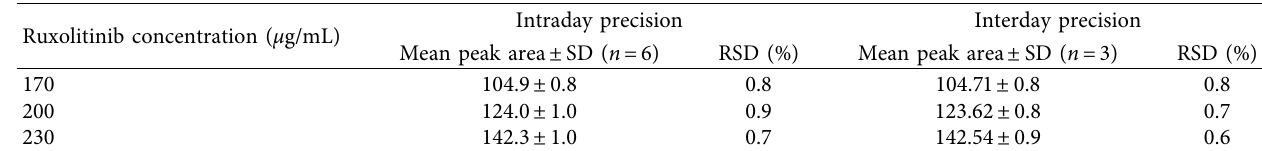
Table 2: Results from the study of precision.